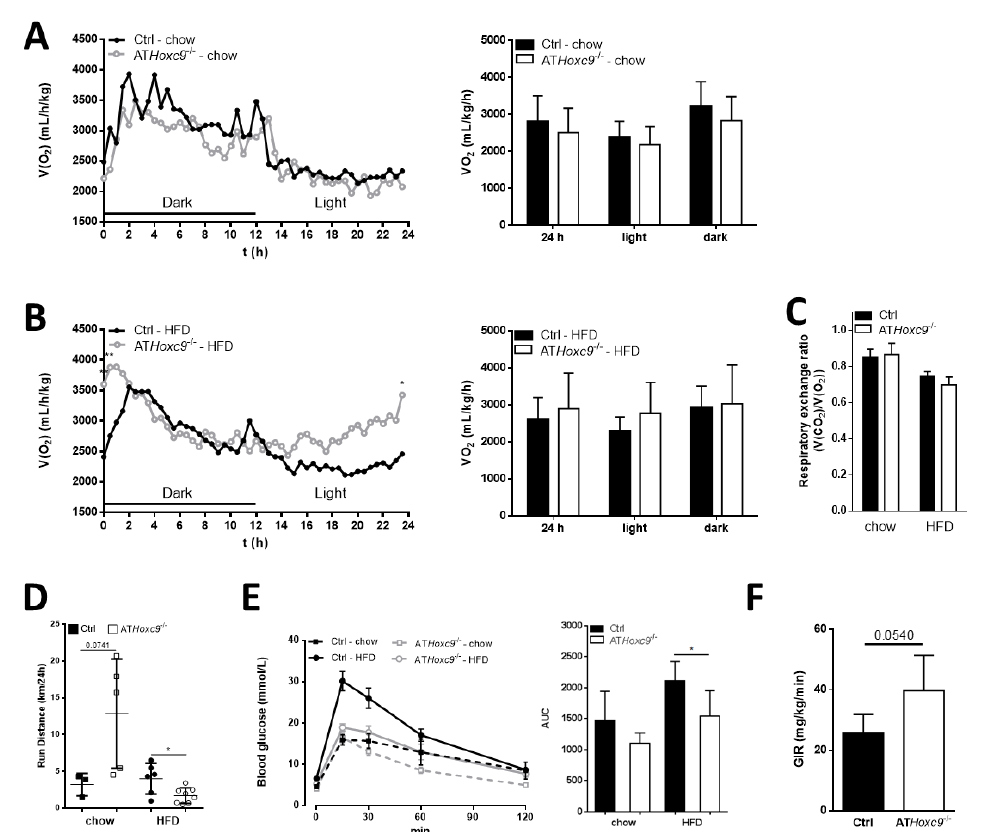
Figure 5. Metabolic parameters of AT Hoxc9 deficient mice. ( A – C ) Oxygen consumption and respiratory exchange rate (RER, C ) were not altered by the presence or absence of Hoxc9 in AT in chow ( A ) or in HFD fed mice ( B ). ( D ) Run distance measurements revealed contrary results with respect to diet. Whereas chow-fed AT Hoxc9 - / - mice tended to run more than littermate controls, they behaved oppositely under HFD. ( E ) Male AT Hoxc9 - / - mice showed better glucose tolerance under HFD compared to control animals during intraperitoneal glucose tolerance tests (GTT) after 25 weeks of age. ( F ) Hyperinsulinemic-euglycemic clamps were performed in chow diet animals at 23–25 weeks of age to determine insulin sensitivity represented by the glucose infusion rate (GIR,). n ( A – C ) = 6–8, n ( D and E ) = 4–10, n ( F ) = 3–10 mice each group. Data represent the mean ± SEM. * Significantly di ff erent between Ctrl and AT Hoxc9 - / - at p < 0.05.